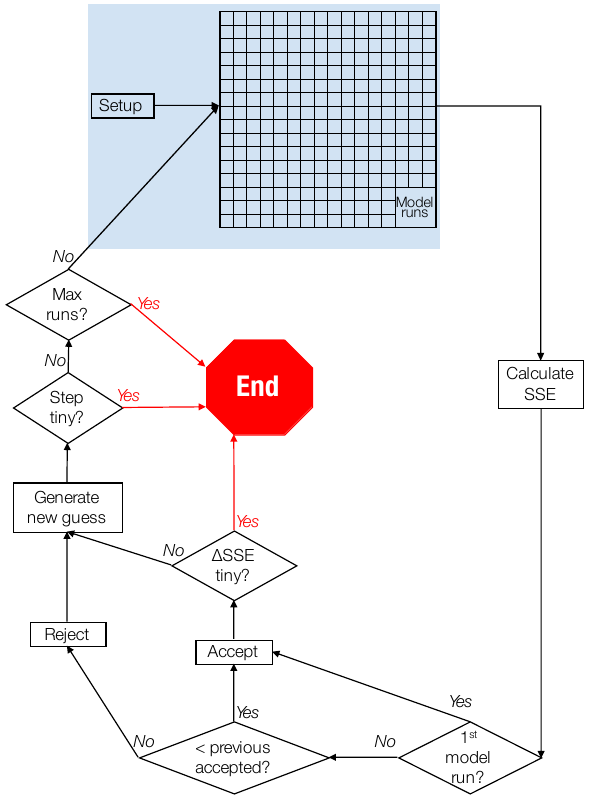
Figure A1. Flowchart describing our implementation of the Levenberg–Marquardt algorithm. Blue shading indicates operations related to running the model; all other steps occur in Python.